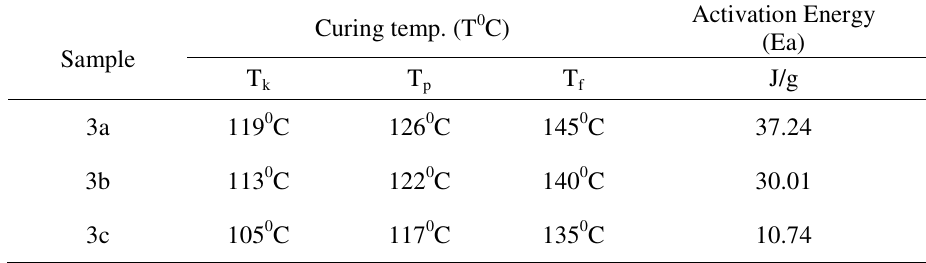
Table 2. DSC curing of epoxy resin